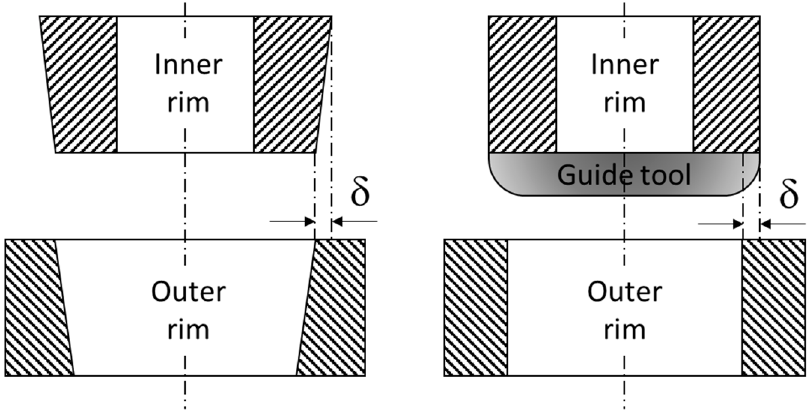
Figure 2. Examples of rotor rim geometries to facilitate press fitting. Adapted from [15].